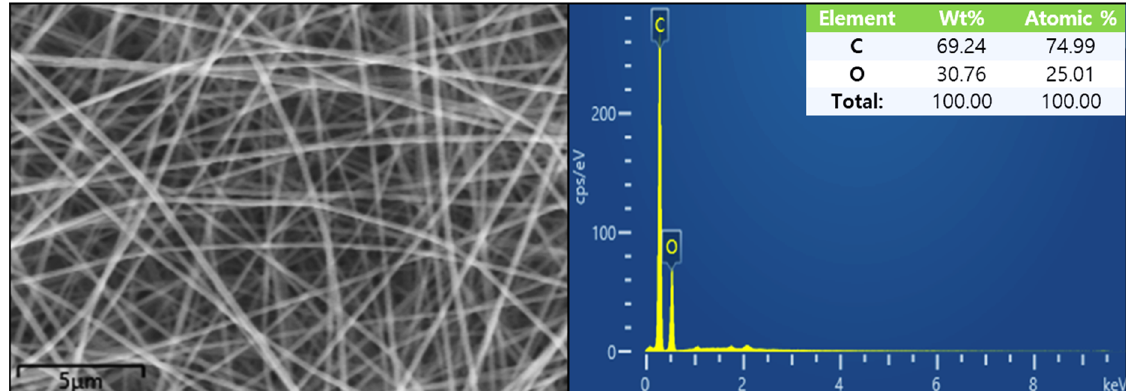
Figure 4. EDS spectra of PVA fibers prepared from the PVA solution at concentration of 10 wt%.